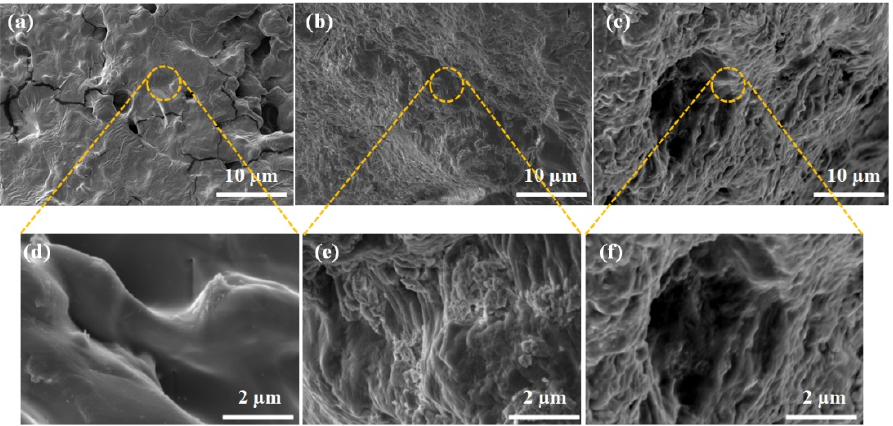
Figure 3. SEM image of composite hydrogel after freeze-drying ( a , d ) CZCNOs, ( b , e ) MZCNOs, and ( c , f ) UZCNOs, respectively. ( d – f ) Indicates the high magnification SEM images of CZCNOs, MZCNOs, and UZCNOs hydrogels, respectively.